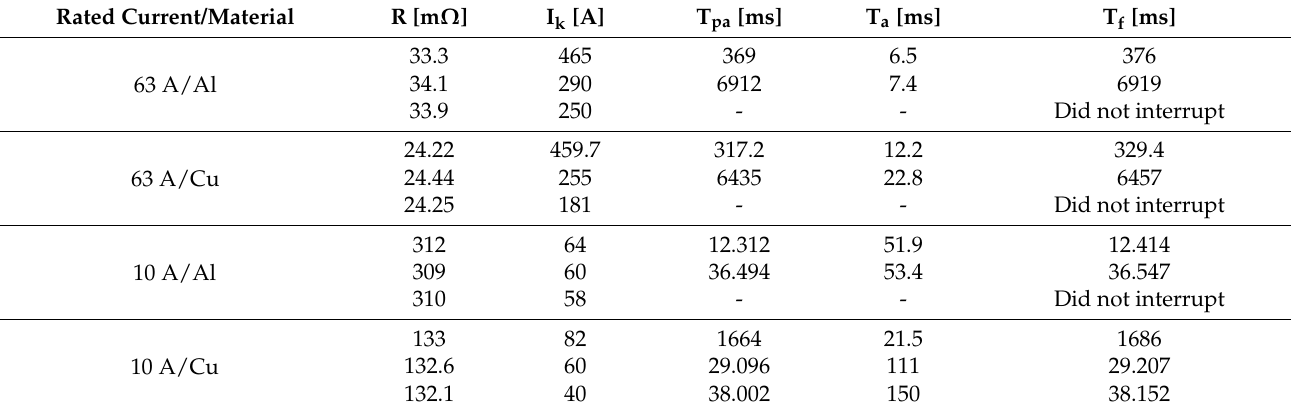
Table 2. Values obtained for the time–current